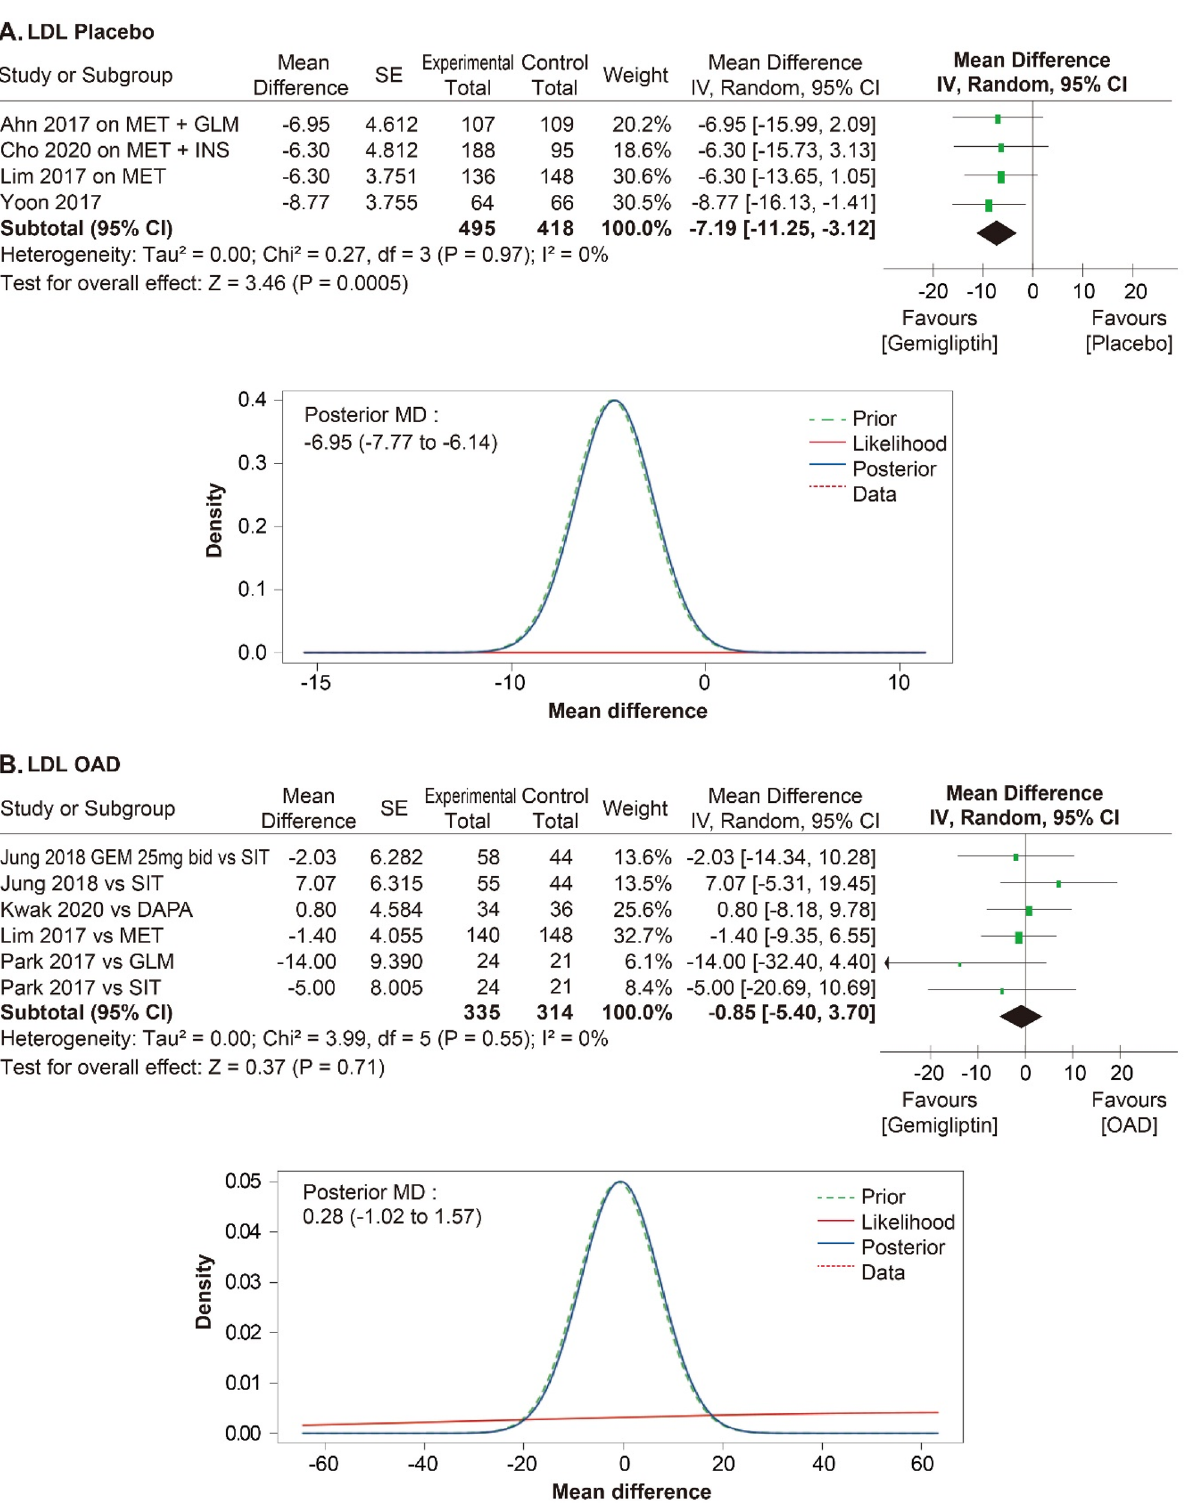
Figure 7. Forest plot of RCTs for the effect of gemigliptin on